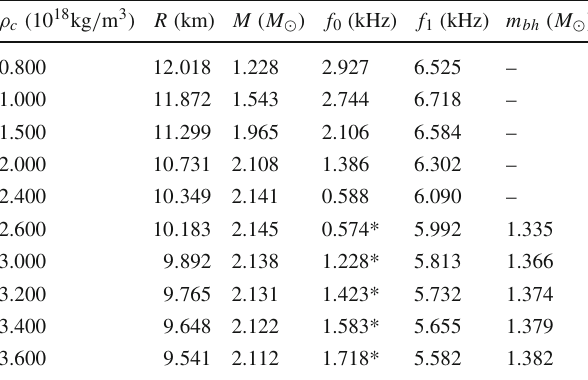
Table 3 Data for β BL = 0 . 2 with SLy EoS in the radial pressure and anisotropy ansatz (32)